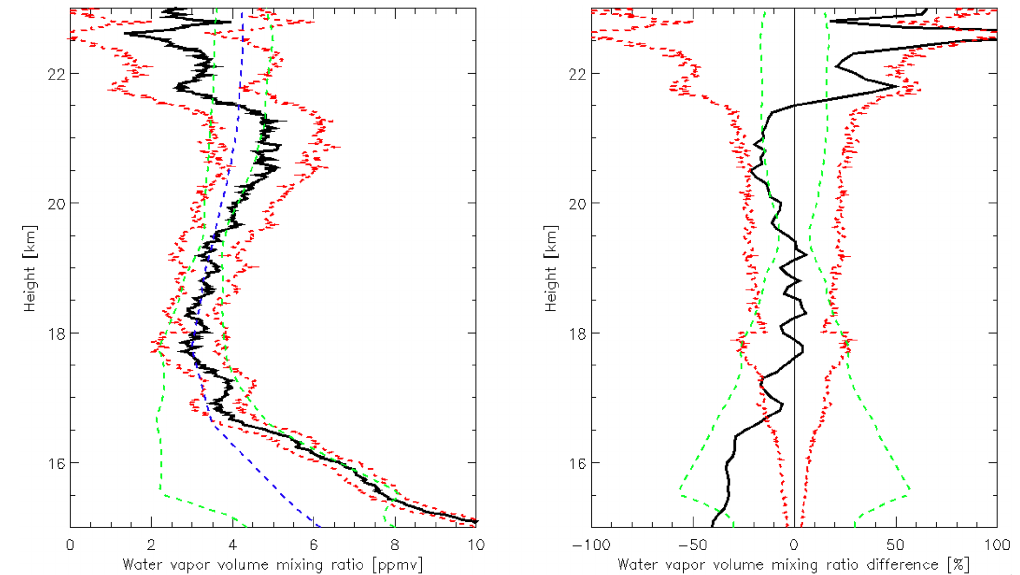
Figure 12. Left plot: UTLS water vapor measurements derived by the lidar campaign-integrated profile (black line) and by the MLS average profile calculated during MALICCA (blue dashed line). Red dotted curves are the associated total lidar error, while green dashed lines represent the mean ± 2- σ of the MLS profile. Right plot: relative difference, 100 × (MLS-Maïdo)/Maïdo, between the lidar and the MLS UTLS water vapor measurement (black line), together with the associated lidar uncertainty and the 2- σ MLS profiles (red dotted and green dashed curves,